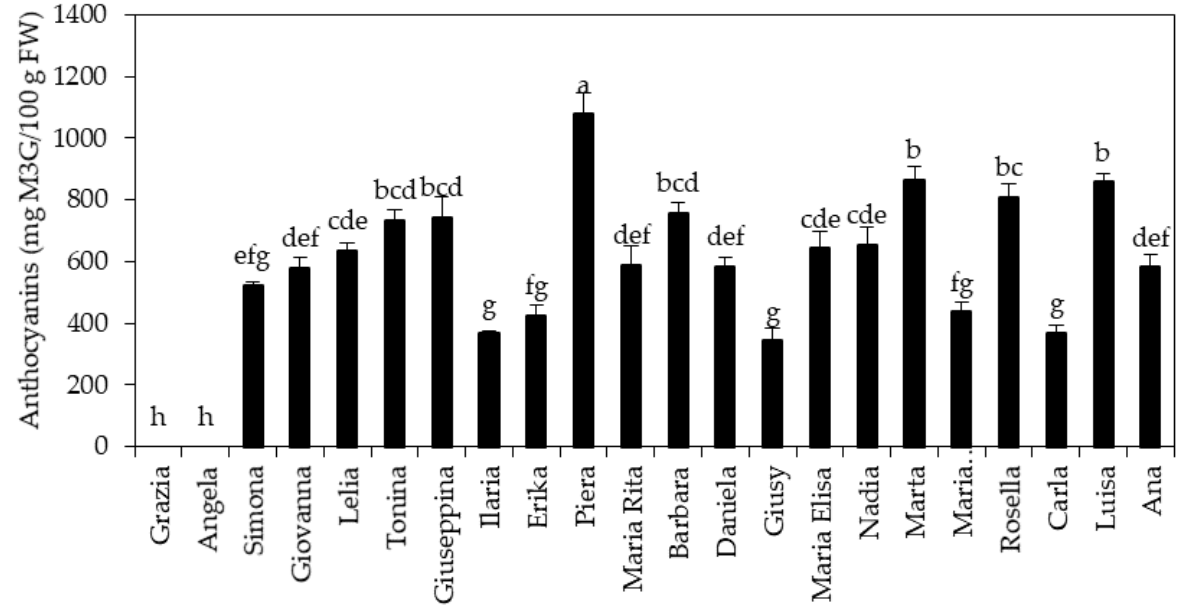
Figure 3. Anthocyanin’s content in berries of 22 myrtle cultivars. The results are expressed as means and standard deviations of three biological replicates. Histograms labelled with different letters indicate values significantly different ( p < 0.05) according to the Tukey test. Hyphen separate a continuous range of letters.